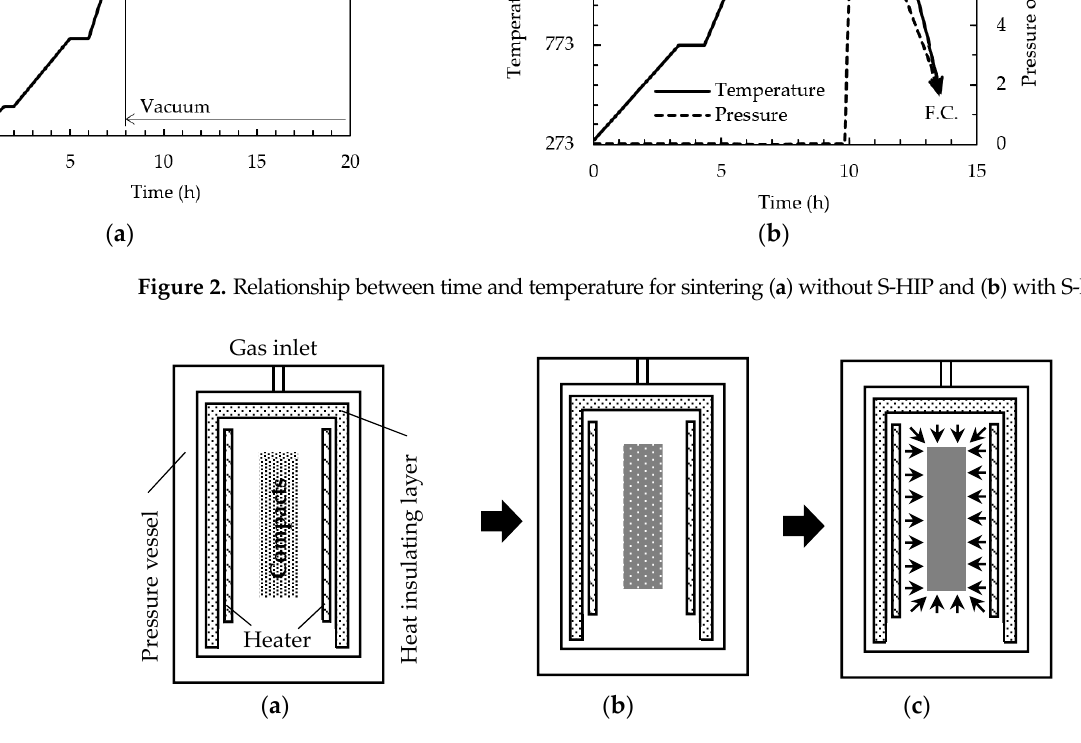
Figure 3. Schematic of HIP furnace and progress of heat treatment. ( a ) Degreasing in